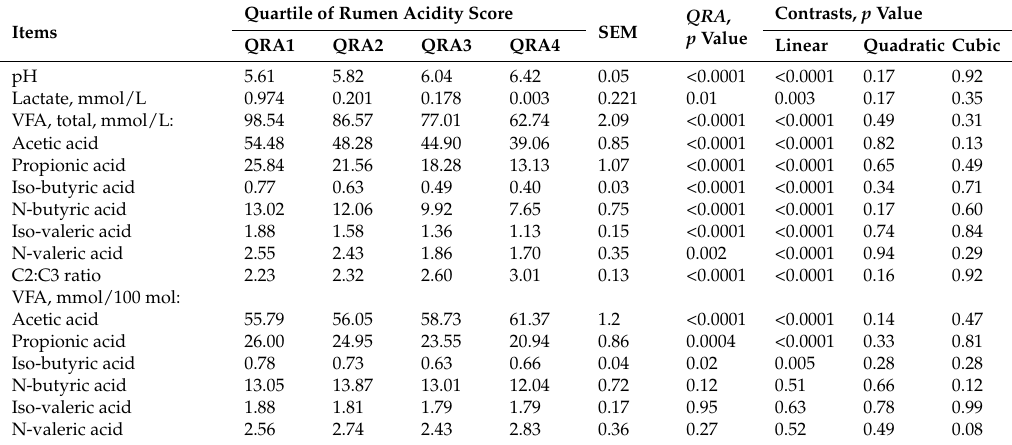
Table 3. Effect of the quartile of rumen acidity score (QRA1, greatest rumen acidity, to QRA4, lowest rumen acidity) on pH, lactate and volatile fatty acid (VFA) content and proportion on the rumen fluid of Holstein